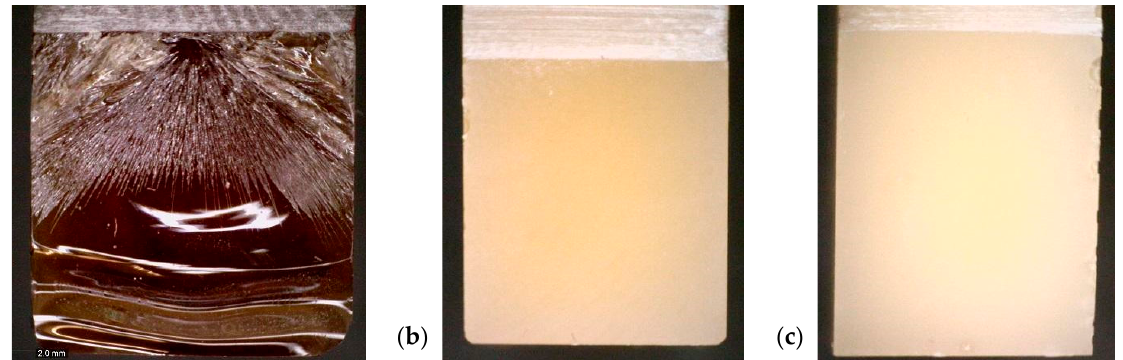
Figure 13. The fracture surface of samples after fracture toughness tests: ( a ) neat resin ( b ) 30 phr ATH ( c )50 phr ATH.